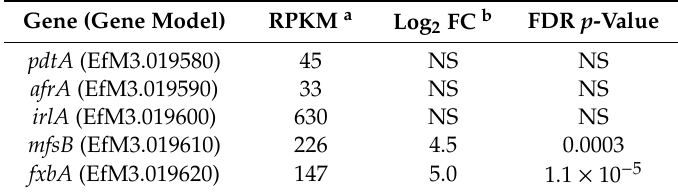
Table 5. Expression of genes of the five-gene cluster proposed by Berry [50] to be involved in regulation of stroma